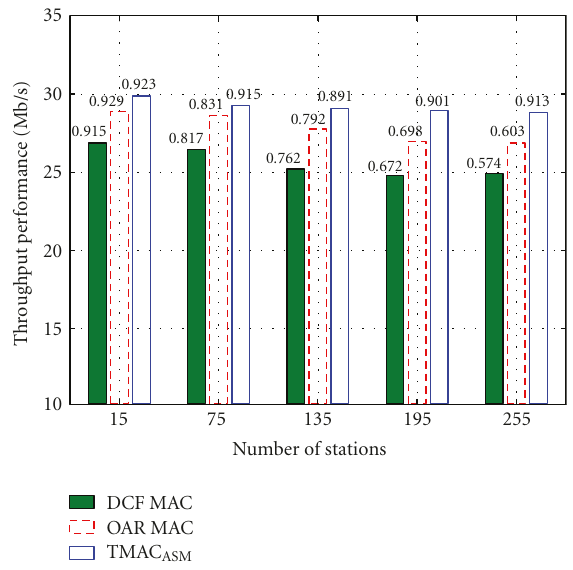
Figure 6: Network throughput in TCP experiments.